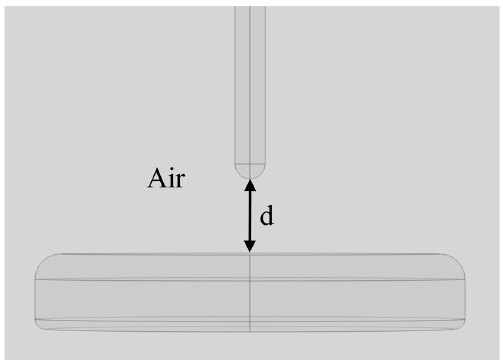
Figure 18. The 3D model of rod (R = 6 mm)–plane electrode system.